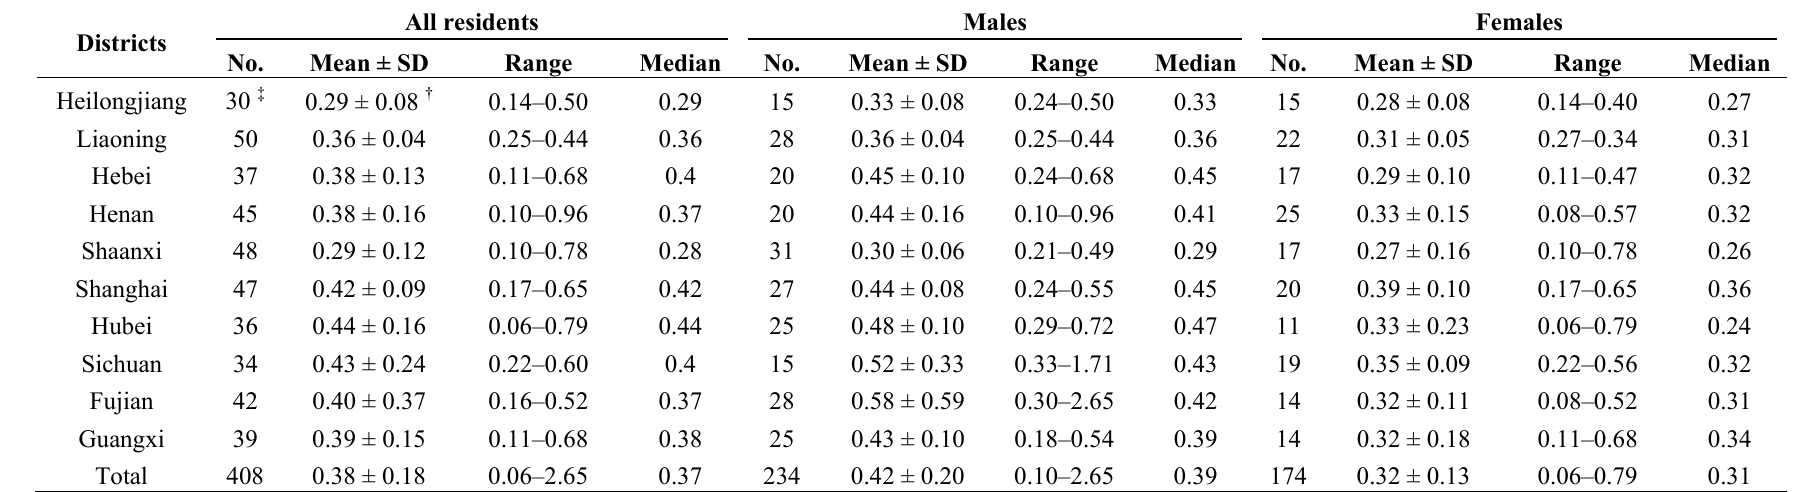
Table 1. Hair Se content of residents in different Chinese districts